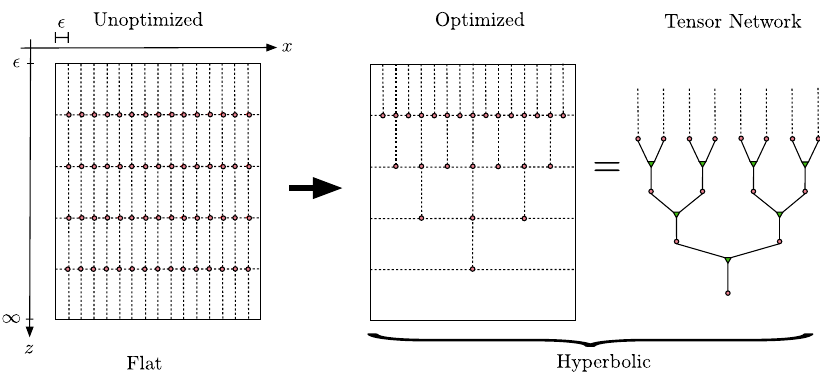
Figure 1 . Representation of the optimization procedure of Euclidean path integrals. The small pink circles represent lattice sites. On the left side, the computation of the ground state wavefunc- tional from the Euclidean path integral (2.1) on a flat unoptimized background. On the middle, the optimized path integral described by a hyperbolic geometry. On the right, a tensor network representation of the optimized hyperbolic geometry where only the coarse-graining procedure of lattice sites is